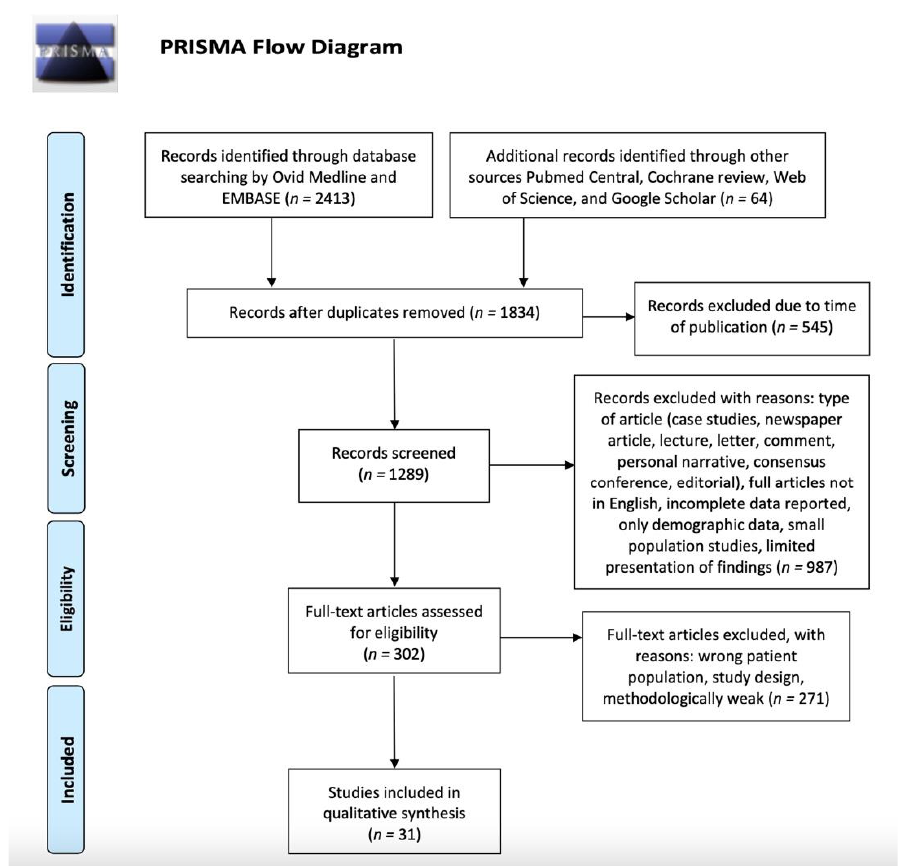
Figure 1. Flowchart of article search and selection according to the PRISMA criteria.